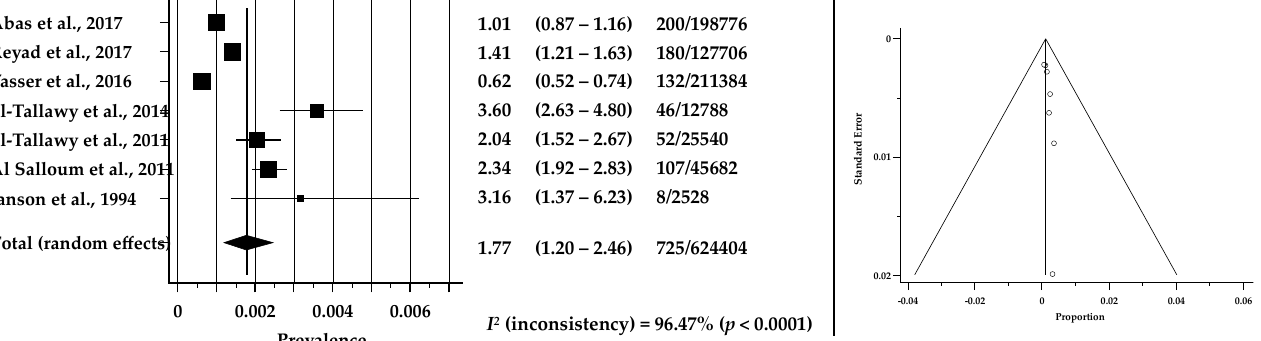
Figure 2. Forest plot (to the left) shows the pooled estimates of prevalence of CP among children and adolescents in Arabic-speaking countries. Assessment of publication bias by Funnel plot (to the right) shows individual study estimates against corresponding standard errors (Kendall’s Tau = 0.4286, p = 0.1765). I 2 suggests considerable heterogeneity between studies.